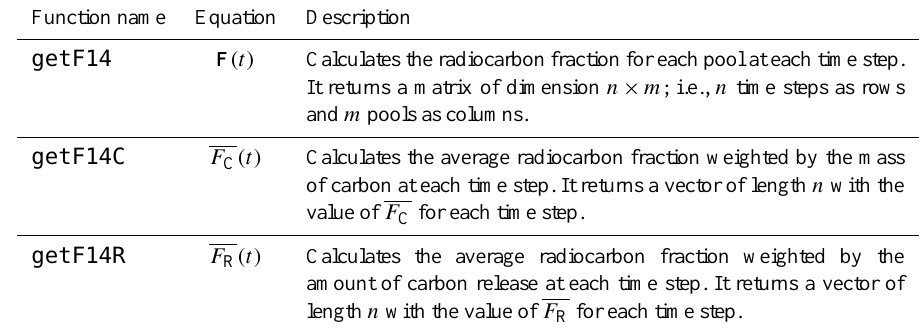
Table 1. Main functions implemented in S OIL R version 1.1 to calculate the radiocarbon fraction in soil organic matter. Function name Equation Description getF14 F (t) Calculates the radiocarbon fraction for each pool at each time step. It returns a matrix of dimension n × m ; i.e., n time steps as rows and m pools as columns. getF14C F C (t) Calculates the average radiocarbon fraction weighted by the mass of carbon at each time step. It returns a vector of length n with the value of F C for each time step. getF14R F R (t) Calculates the average radiocarbon fraction weighted by the amount of carbon release at each time step. It returns a vector of length n with the value of F R for each time